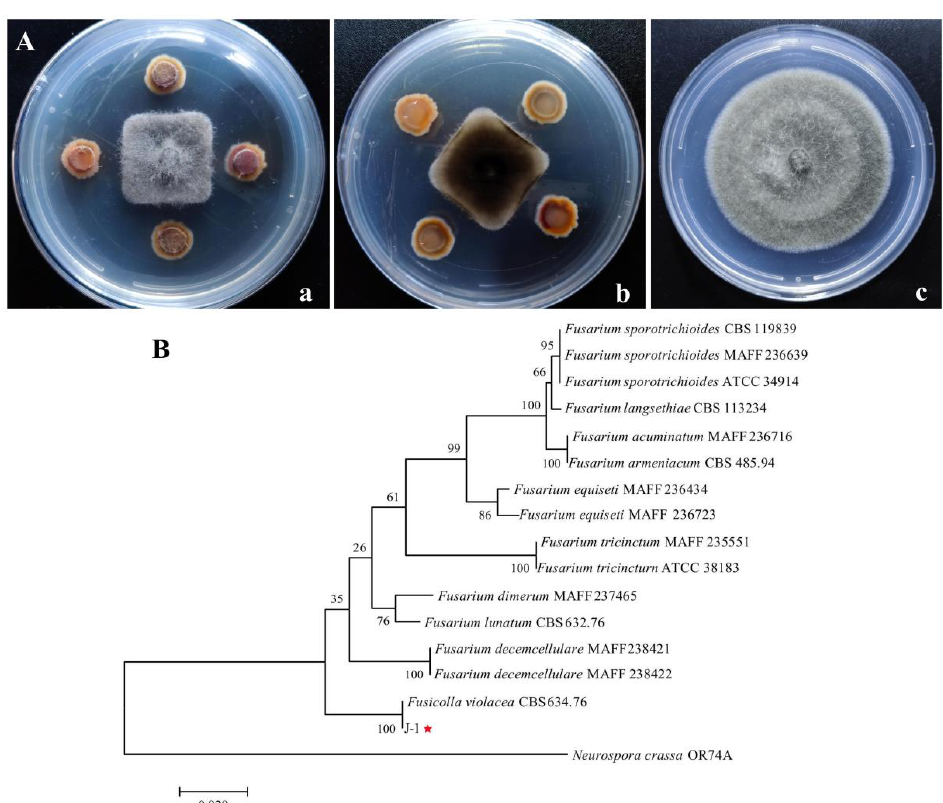
Figure 1. Identification of strain J-1 with high antagonistic activity against A. alternata . ( A ) In vitro inhibition activity; ( a ) Surface view of colony; ( b ) Back view of colony; and ( c ) Control. ( B ) A phylogenetic tree based on 18S rDNA and β -tub sequences constructed using the maximum likelihood (ML) method in MEGA 7.0 software with bootstrap values based on 1000 replications. Note: the red star indicate antagonistic strain.